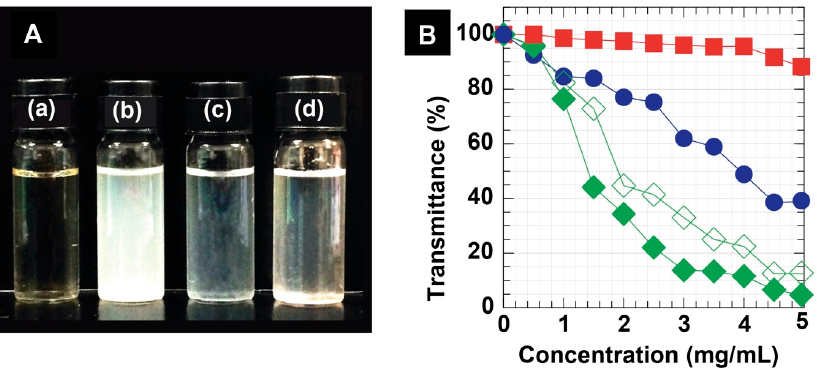
Figure 3. ( A ) Physical appearance of ( a ) WCS, ( b ) DC-WCS in water, ( c ) DC-WCS in ethanol, and ( d ) DC-WCS-PG in water at 1.5 mg/mL. ( B ) Transmittance (%) at a wavelength of 600 nm for WCS ( ), DC-WCS in water ( ), DC-WCS in ethanol ( ), and DC-WCS-PG ( ).